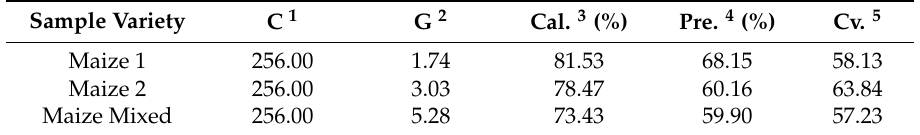
Table 1. The classification accuracy of SVM models using full spectra. Sample